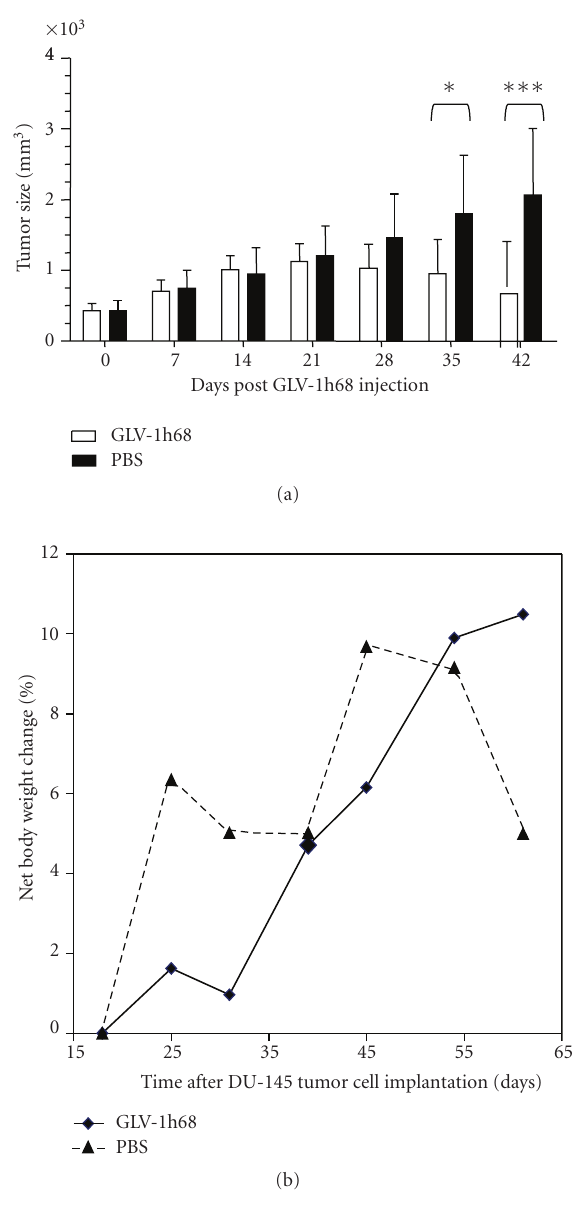
Figure 2: E ff ect of systemic virus injection on DU-145 xenograft tumors. (a) DU-145 tumor development in mice after GLV-1h68- treatment versus PBS treatment. Two-way analysis of variance (ANOVA) with Bonferroni posttest was used to compare the two corresponding data points of the two groups. P < . 05 was considered as statistically significant ∗ P < . 05; ∗∗ P < . 01; ∗∗∗ P < . 001. (b) Body weights of DU-145 cell xenografted mice after virus treatment.